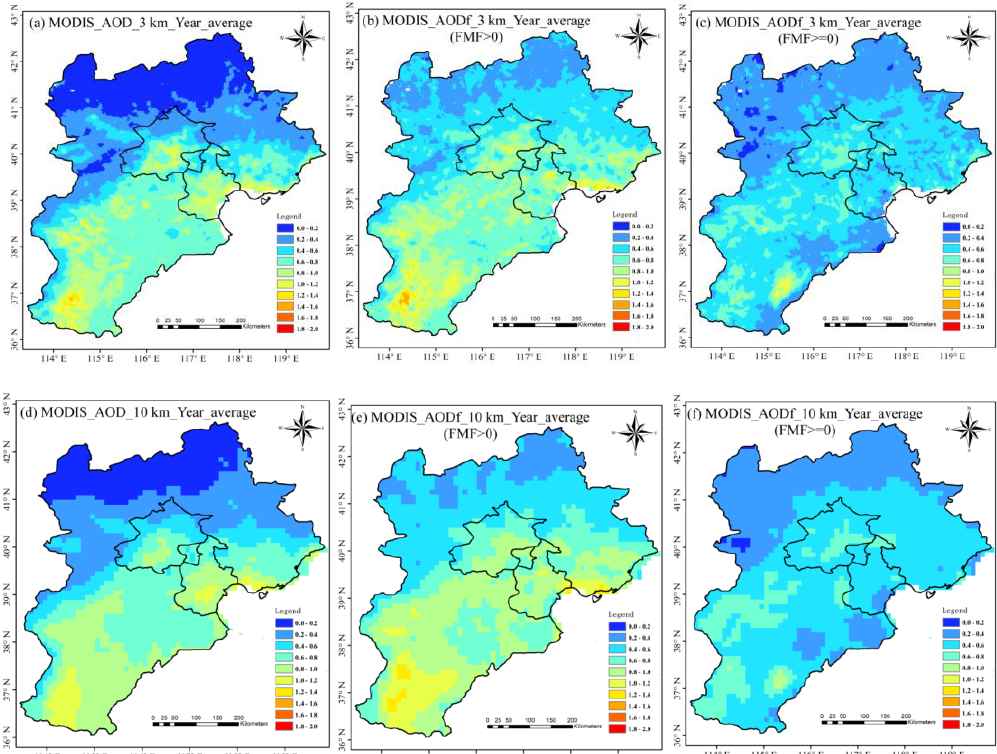
Figure 2. The yearly averaged aerosol products of MODIS for 3 and 10 km, (a) and (d) are the AOD at 550 nm, (b) and (e) are the AOD f at 550 nm when FMF >0, (c) and (f) are the AOD f at 550 nm when FMF ≥ 0.